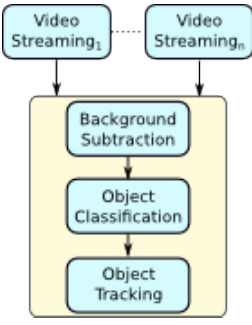
Figure 3. Image processing logic